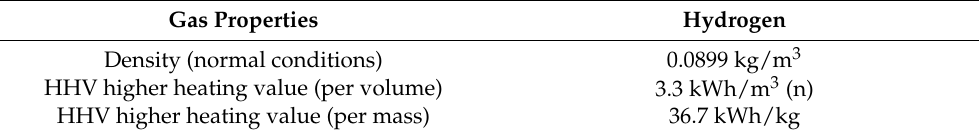
Table 4. Hydrogen properties